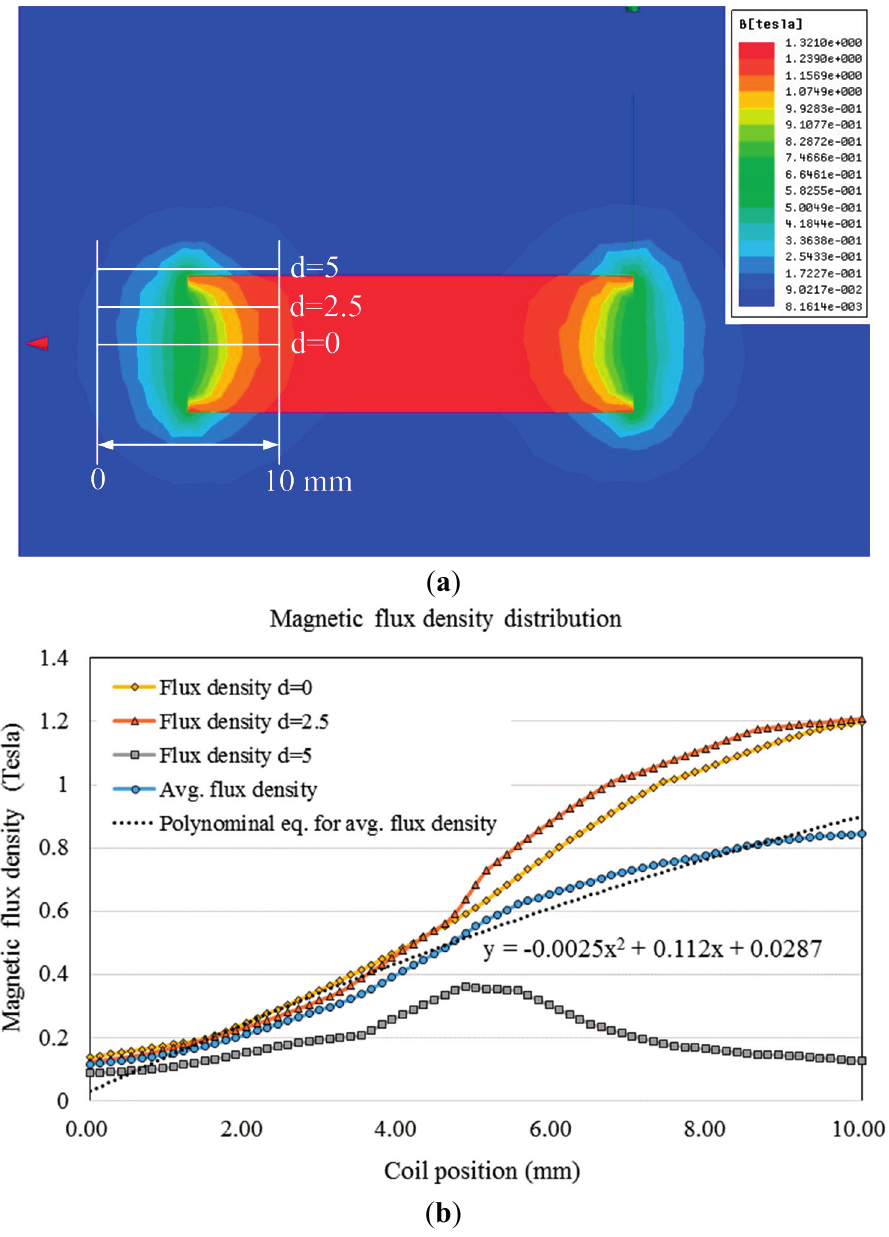
Figure 8. Magnetic flux density simulation. ( a ) Magnetic field strength of the cylindrical magnet for the NSEH in the x component simulated using Maxwell. ( b ) Magnetic flux density